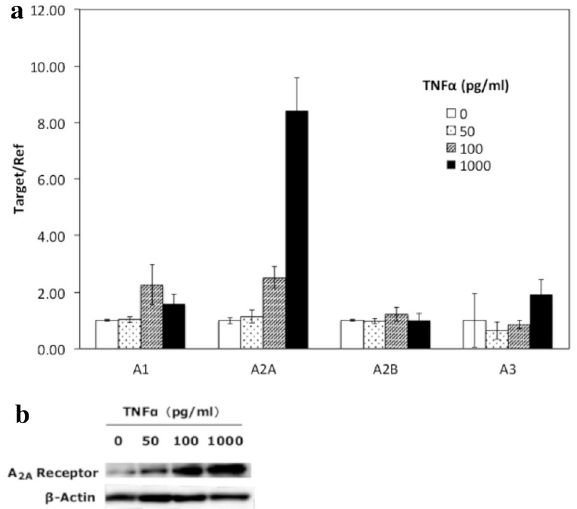
Figure 1. Expression of all four adenosine receptors by MH7A cells. Expression of adenosine A 2A receptors in MH7A cells and enhancement by TNFα. MH7A synoviocytes were incubated for 24 h with the indicated concentrations of TNFα. Adenosine receptor (AdoR) mRNA levels and A 2A AdoR protein in the membrane fraction were then determined by real-time PCR ( a ) and Western blotting ( b ), respectively. Both A 2A AdoR mRNA and membrane protein expression were enhanced by TNFα compared to untreated controls. ß-actin was used as an internal control. Original blots/gels are presented in Supplementary Figs. 1, 2. Experiments were repeated three times and representative data are